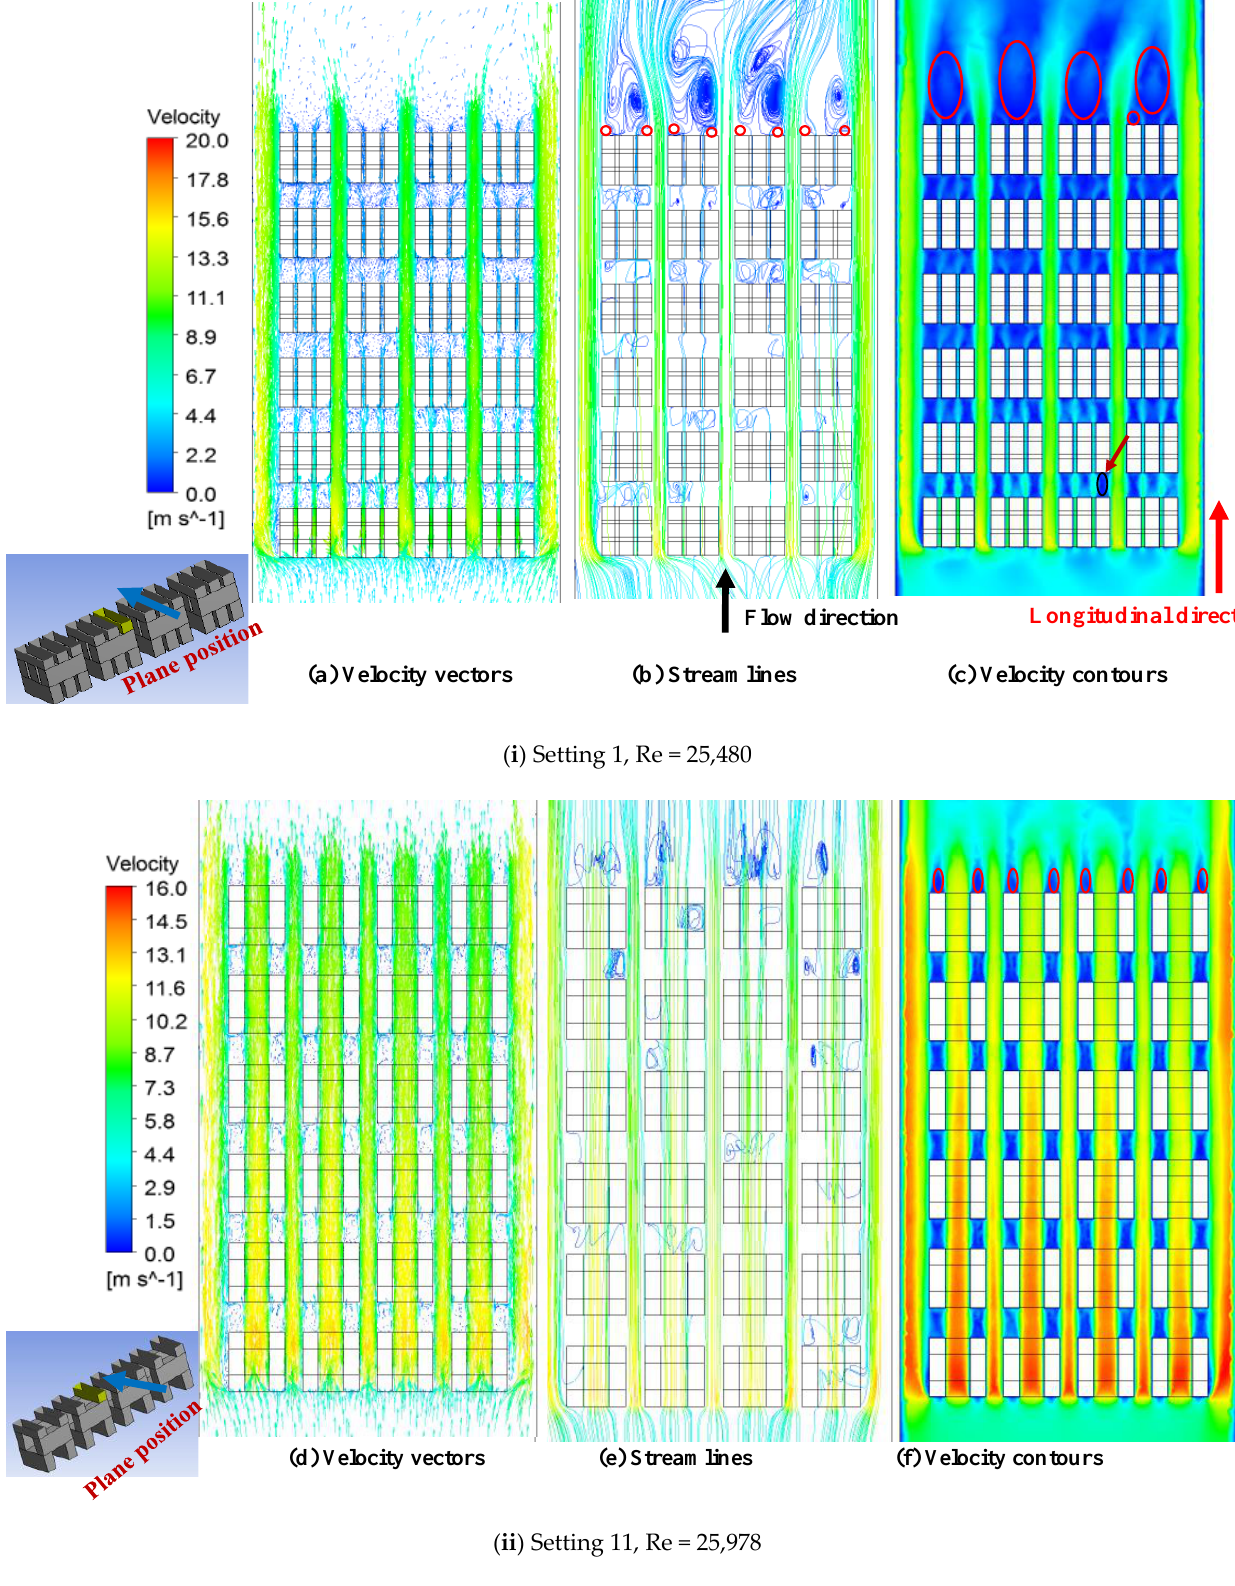
Figure 6. Flow characteristics at the top plane (Top 3) pass through heater 3 for two settings: ( i ) setting 1, and ( ii ) setting 11.